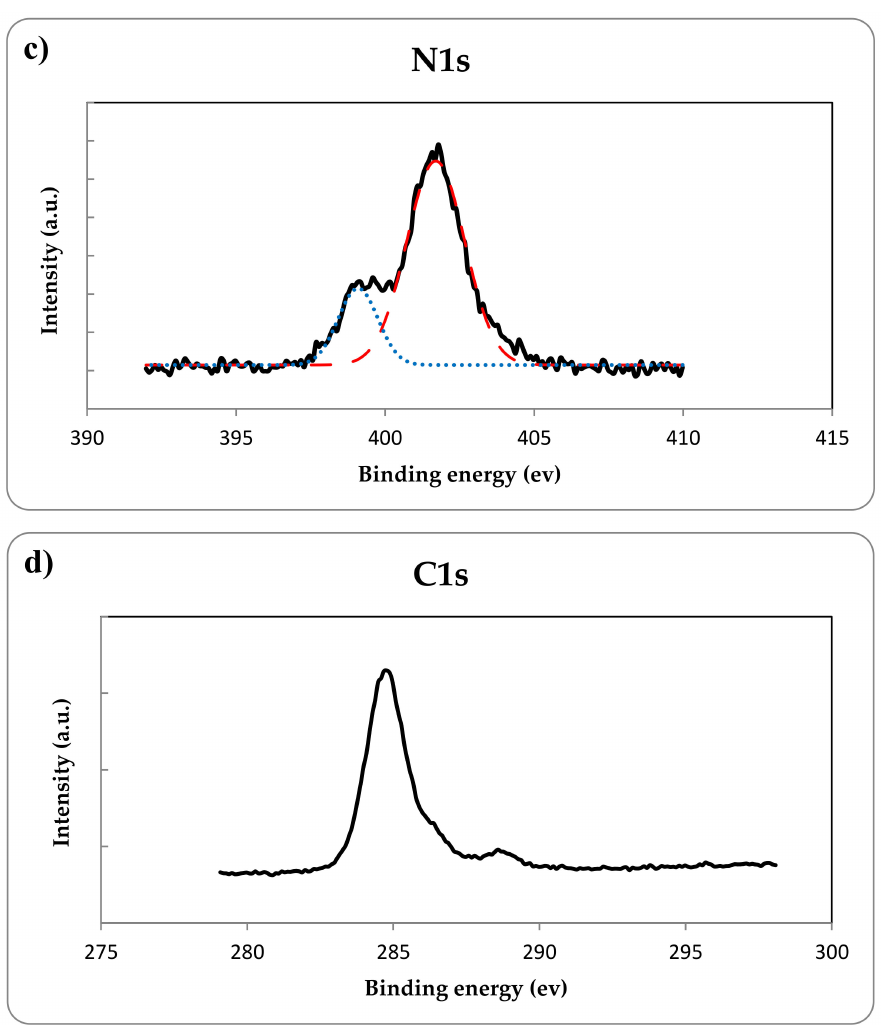
Figure 6. XPS spectra of ( a ) Ti2p, ( b ) O1s, ( c ) N1s and ( d ) C1s for the prepared N-doped TiO 2 . The colored dashed lines stand for the deconvoluted scan of the elements which show all the obtained peaks for each